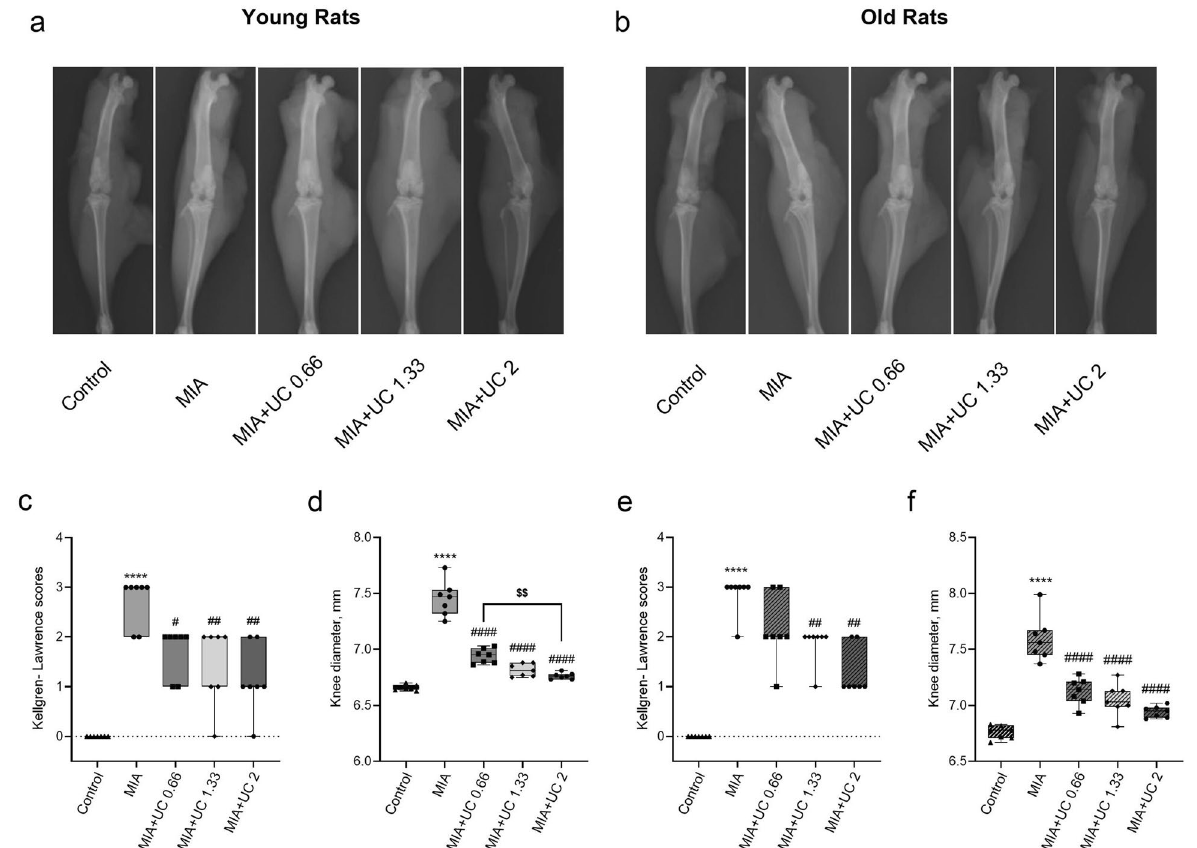
Figure 3. Effects of undenatured collagen (UC) supplementation at different doses on the knee joint in monosodium iodoacetate (MIA) induced osteoarthritis in young (n = 7) and old rats (n = 7). Representative radiographic images ( a for young rats and b for old rats) obtained at the end of the experiment (37 th day) are shown. The depicted box ‐ and ‐ whisker plots represent Kellgren-Lawrence scores ( c for young rats and e for old rats) and knee joint diameter ( d for young rats and f for old rats) with min and max values. For Kellgren- Lawrence scores, Kruskal Wallis and Mann–Whitney U comparison test were used to compare the results among different treatment groups. ANOVA and Tukey’s post hoc test were used for joint diameter data to compare the results among different treatment groups. Statistical analysis was performed separately within each age group. Statistical significance between groups is shown by: **** p < 0.0001 (MIA vs. Control), # p < 0.05; ## p < 0.01 #### p < 0.0001 (MIA vs. UC groups), and $$ p < 0.01 (pairwise comparisons between UC